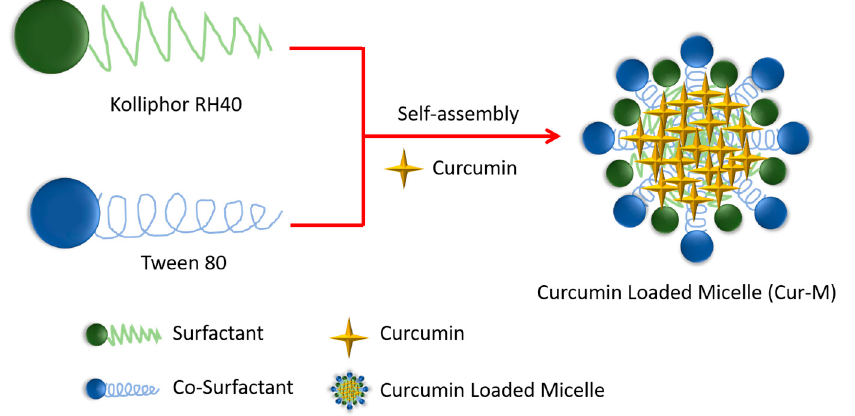
Figure 1. Schematic illustration for the preparation of the Cur-M. Table 1. Compositions and physical characterizations of micelle formulations. Micelle: void vector of the OFSAS (oil-free self-assembly systems); Cur-M: curcumin-loaded self-assembled micelle.